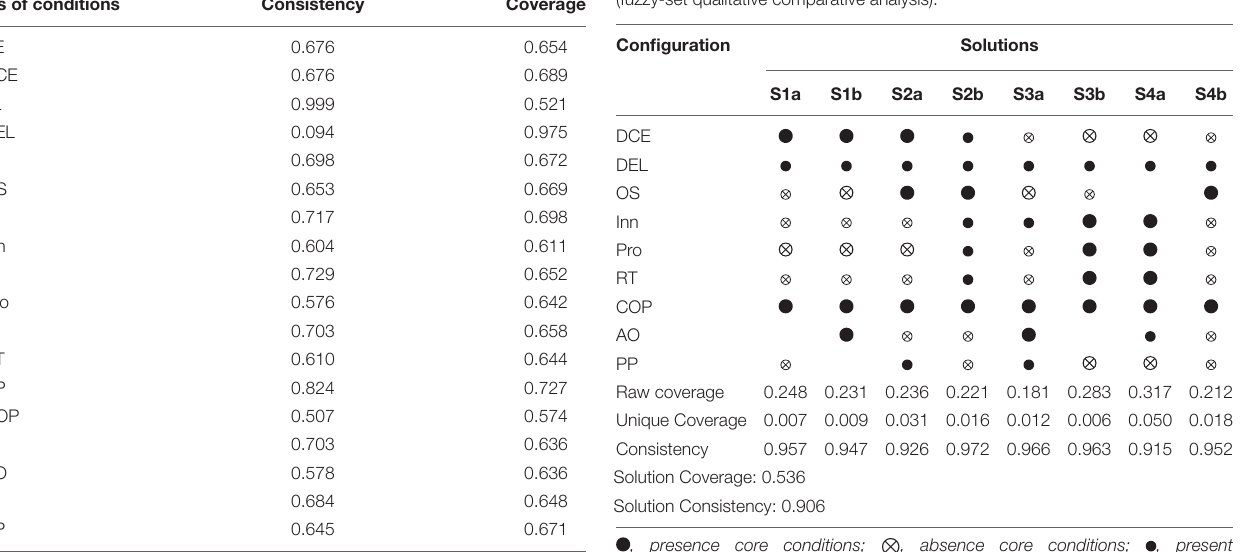
TABLE 3 | Configurations for high middle management team innovativeness (fuzzy-set qualitative comparative